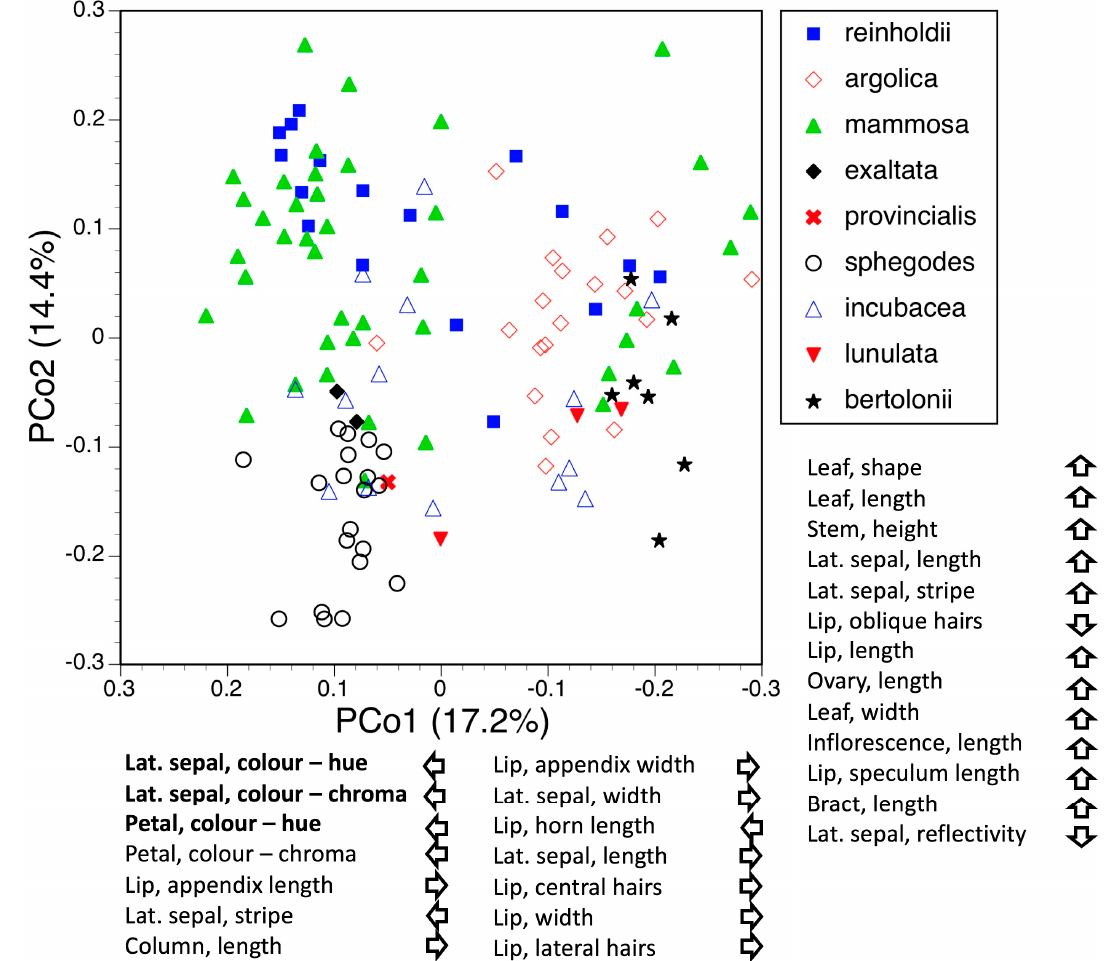
Figure 7. Plot of principal coordinates 1 and 2 for the macrospecies Sphegodes, labelled according to nine mesospecies groups: 124 individuals from 104 localities and 51 variable characters. Characters contributing to each coordinate are listed in descending order, with arrows indicating the direction of increase in the value of each character (boldface characters dominate that